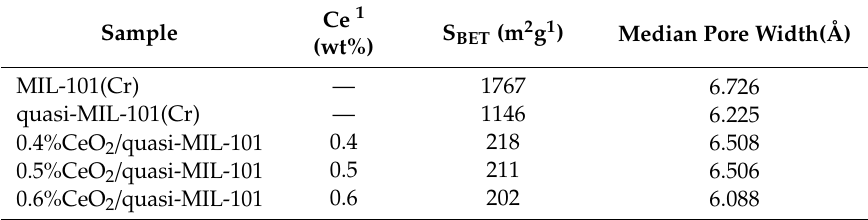
Figure 4. xCeO 2 / quasi-MIL-101 N 2 adsorption-desorption isotherms and pore size distribution ( a ). 0.4%CeO 2 / quasi-MIL-101; ( b ) 0.5%CeO 2 / quasi-MIL-101; ( c ) 0.6%CeO 2 / quasi-MIL-101; ( d ) Median pore width distribution of xCeO 2 / quasi-MIL-101). Table 1. Ce content and BET surface area over various catalysts.